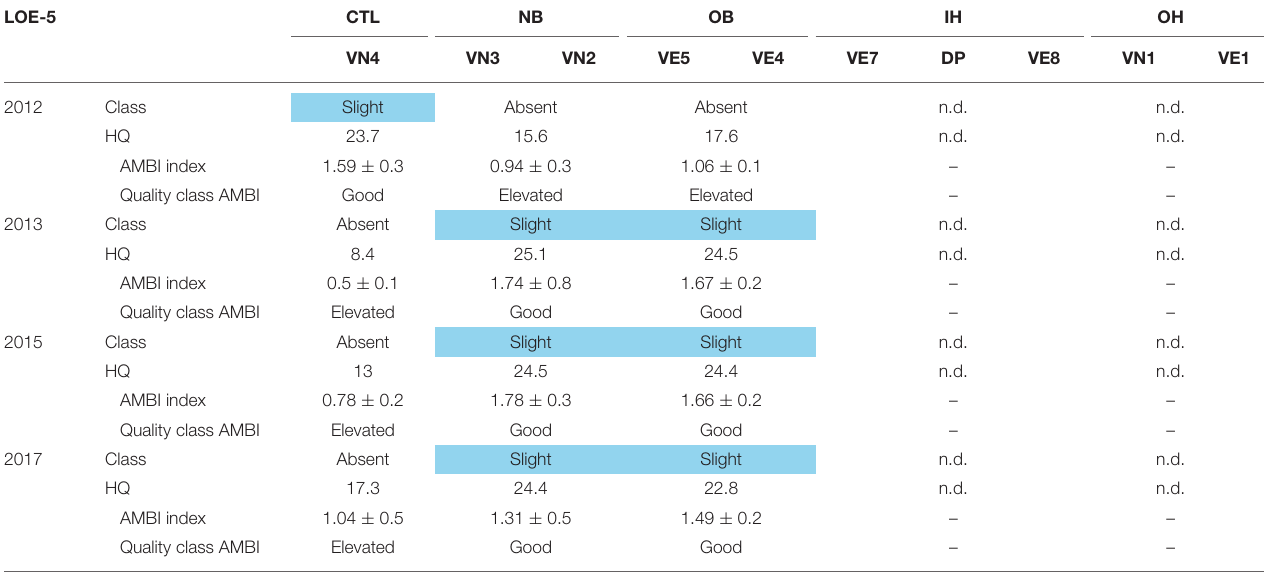
TABLE 5 | LOE-5 (benthic communities) results. LOE-5